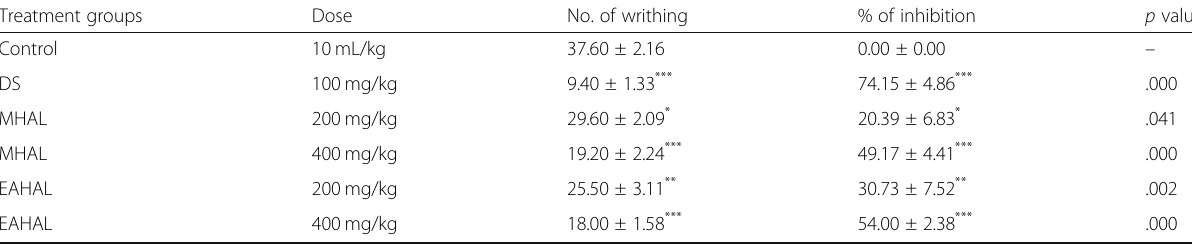
Table 5 Effect of standard and MHAL and EAHAL in acetic acid-induced writhing test Treatment groups